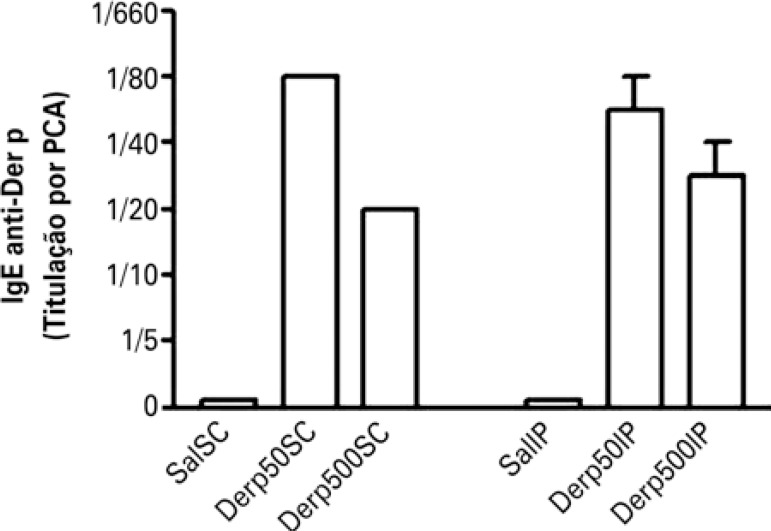
Valores de média ± erro padrão da titulação da IgE específica anti-Dermatophagoides pteronyssinus pela técnica da passive cutaneous anaphylaxis